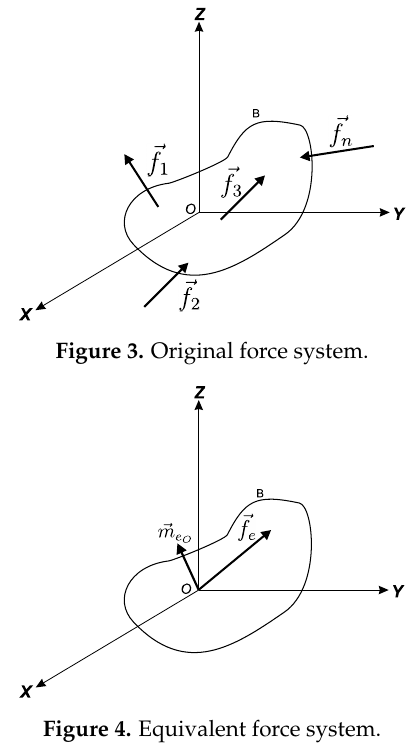
Figure 4. Equivalent force